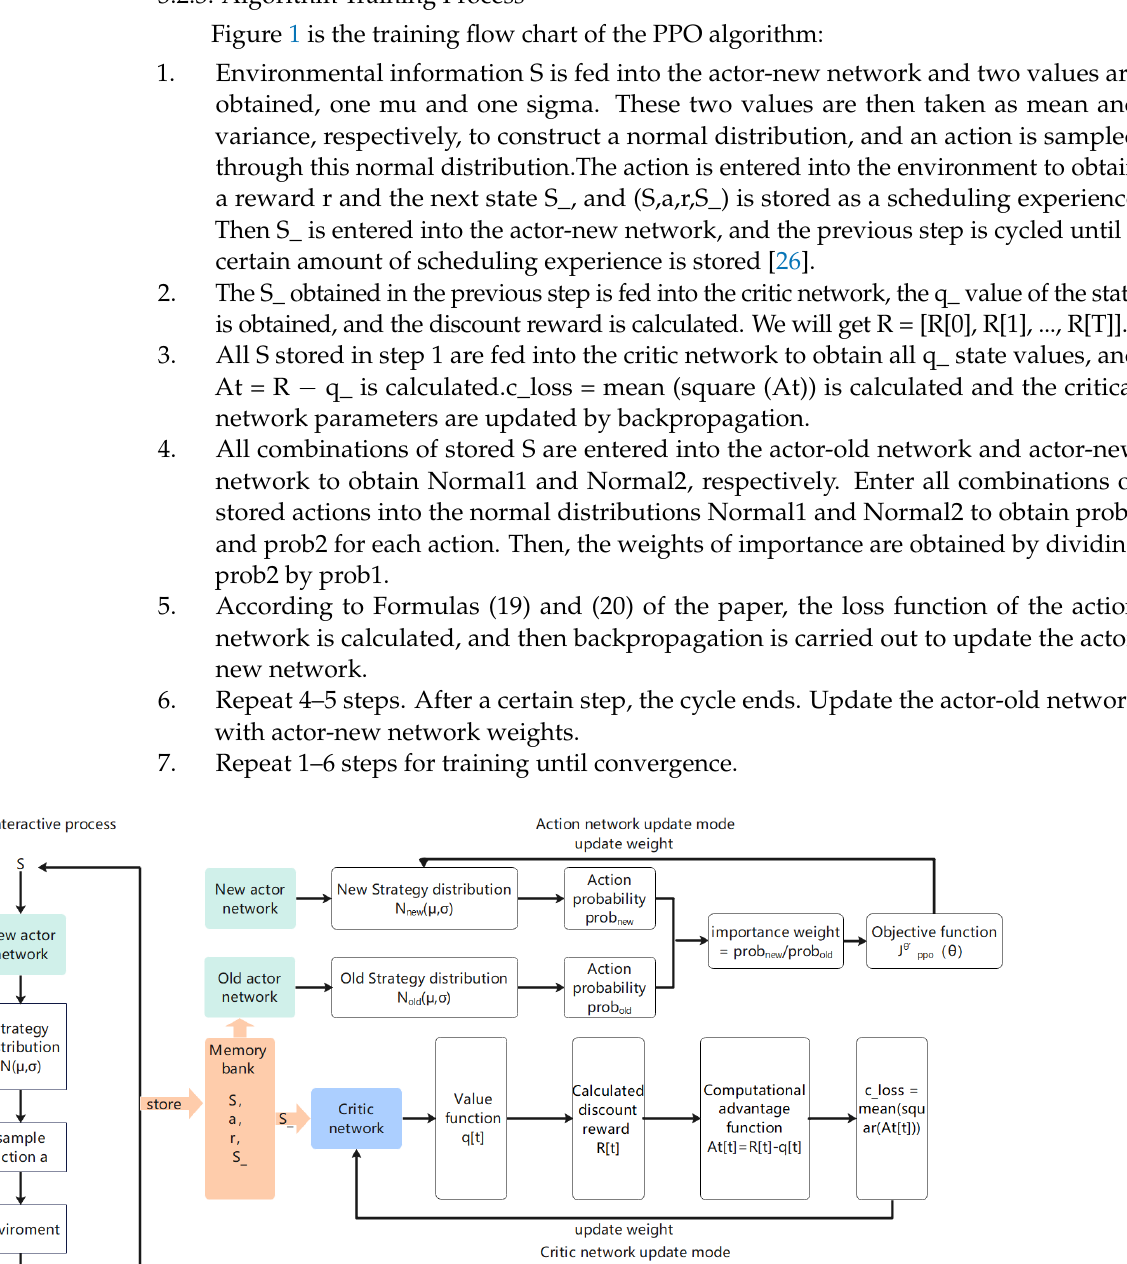
Figure 1 is the training flow chart of the PPO algorithm: